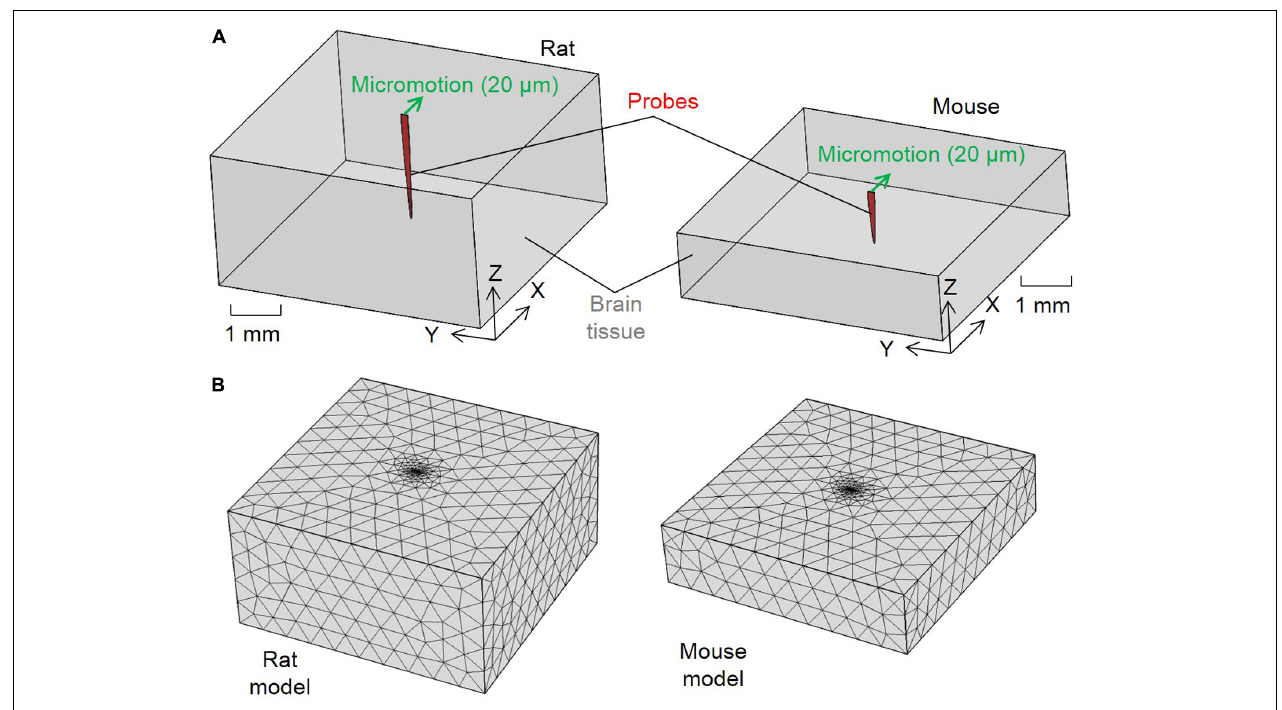
FIGURE 1 | Configurations for the finite element method strain models. (A) Schematics of the model configurations and set up of the micromotion and (B) tetrahedron mesh of the rat and mouse